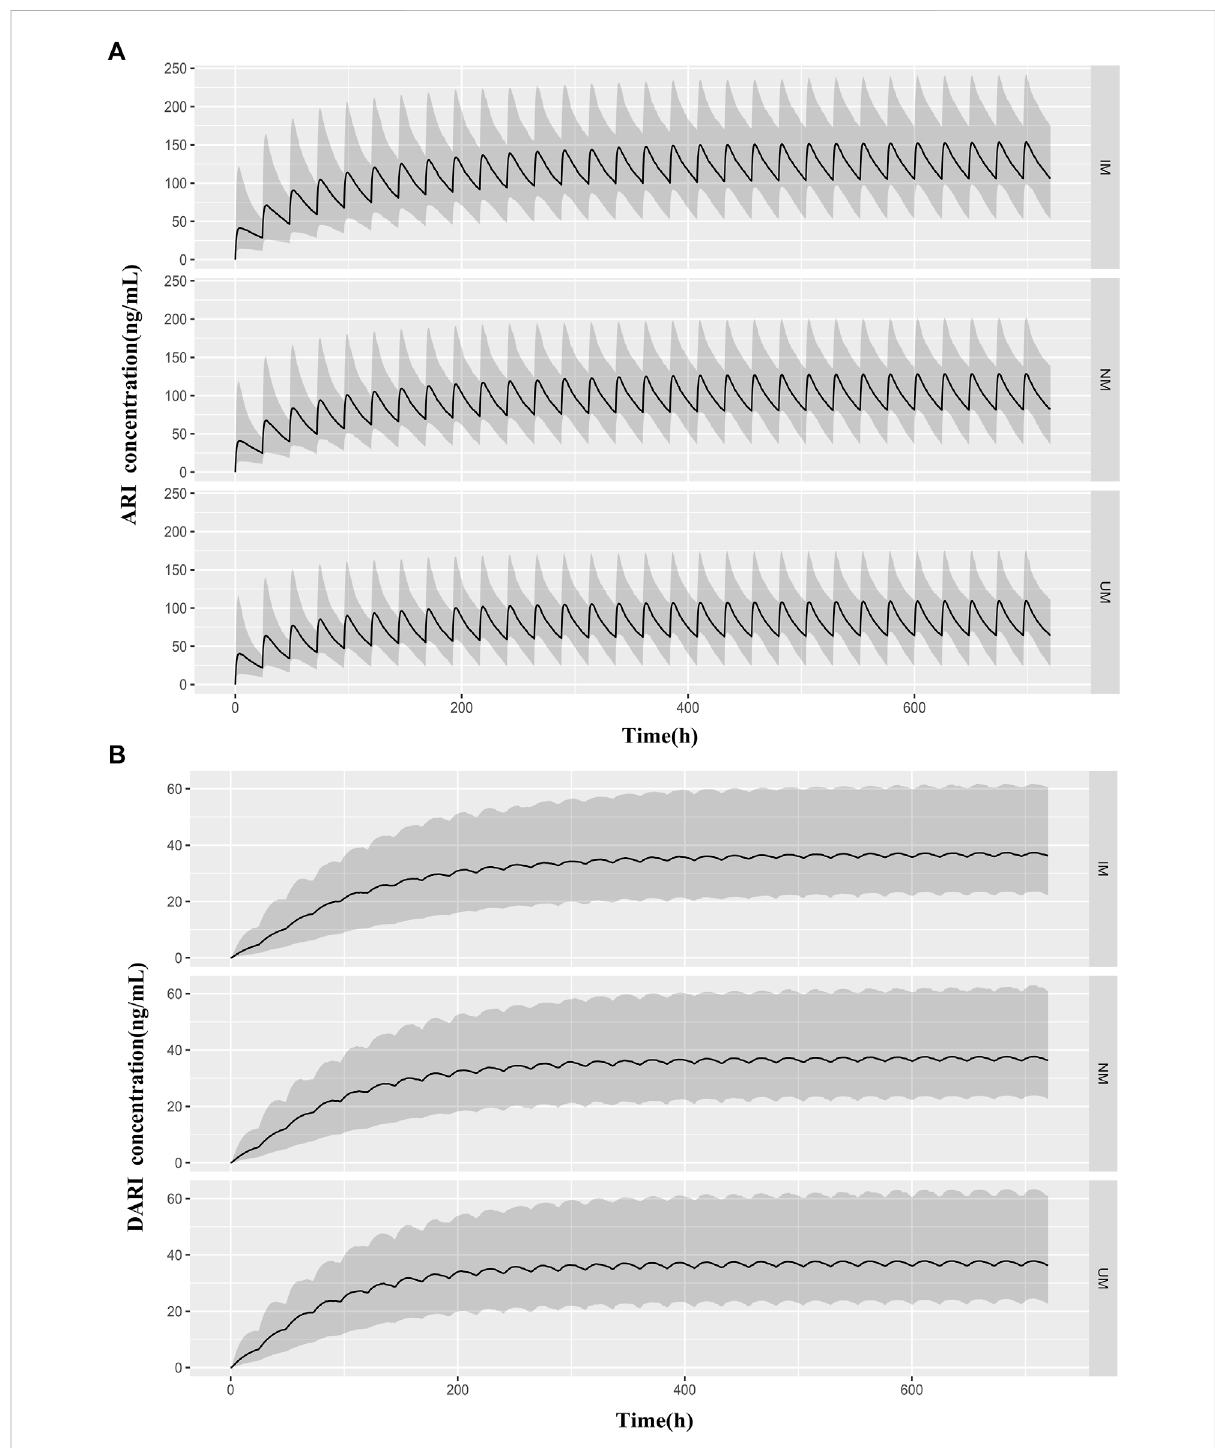
FIGURE 5 Predicted pharmacokinetic pro fi les of ARI (A) and DARI (B) during the fi rst 20 days of treatment obtained from IMs, NMs, and UMs. The median body weight of 36 kg and the median dose of 0.5 mg were applied to simulated. The black line is the median of the simulated concentrations. The grey shaded area represents the prediction interval (10th-90th